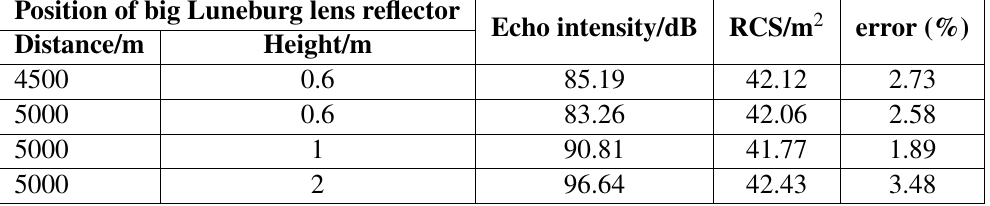
Fig. 7 The RCS of the big Luneburg lens reflector. RCS, radar cross-section. Table 2 The intensity and RCS of the big Luneburg lens reflector at different